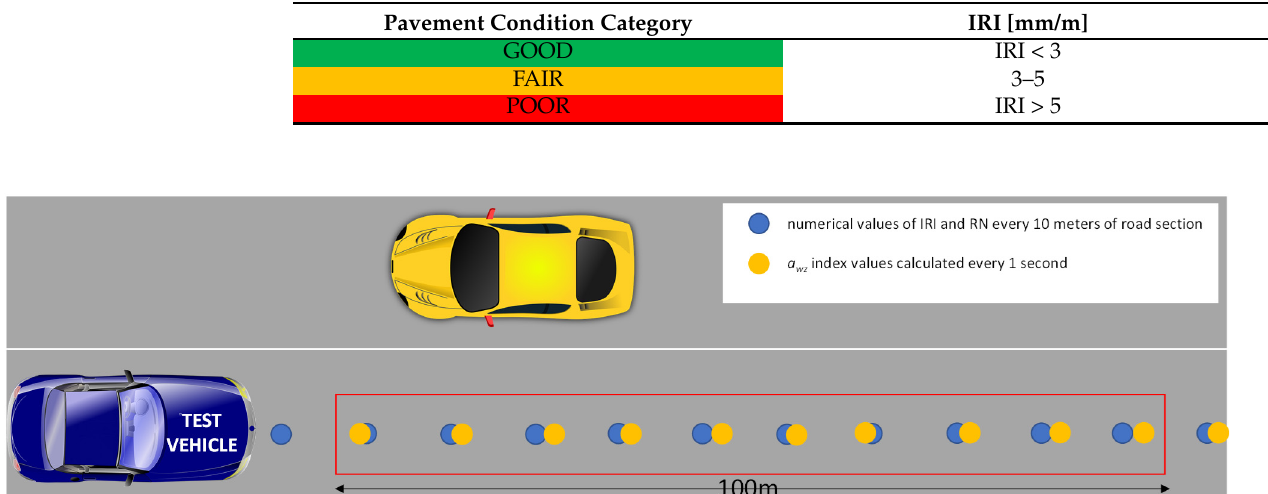
Table 7. Pavement condition category associated to the roughness thresholds considered in this paper.